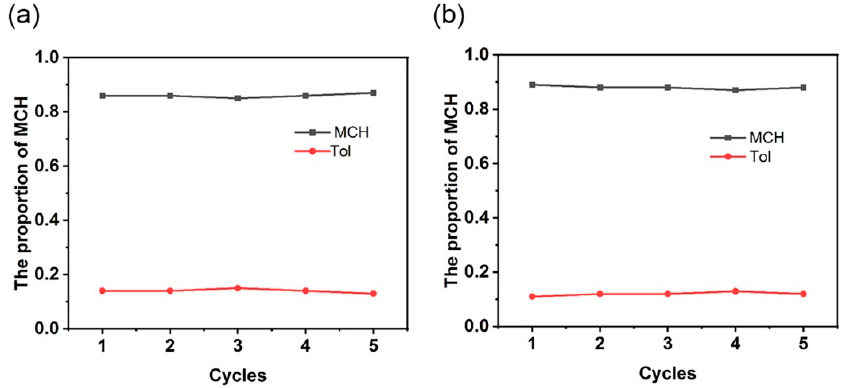
Figure 5. Relative uptakes of MCH and Tol by ( a ) WP5 and ( b ) WP6 for five cycles at 298